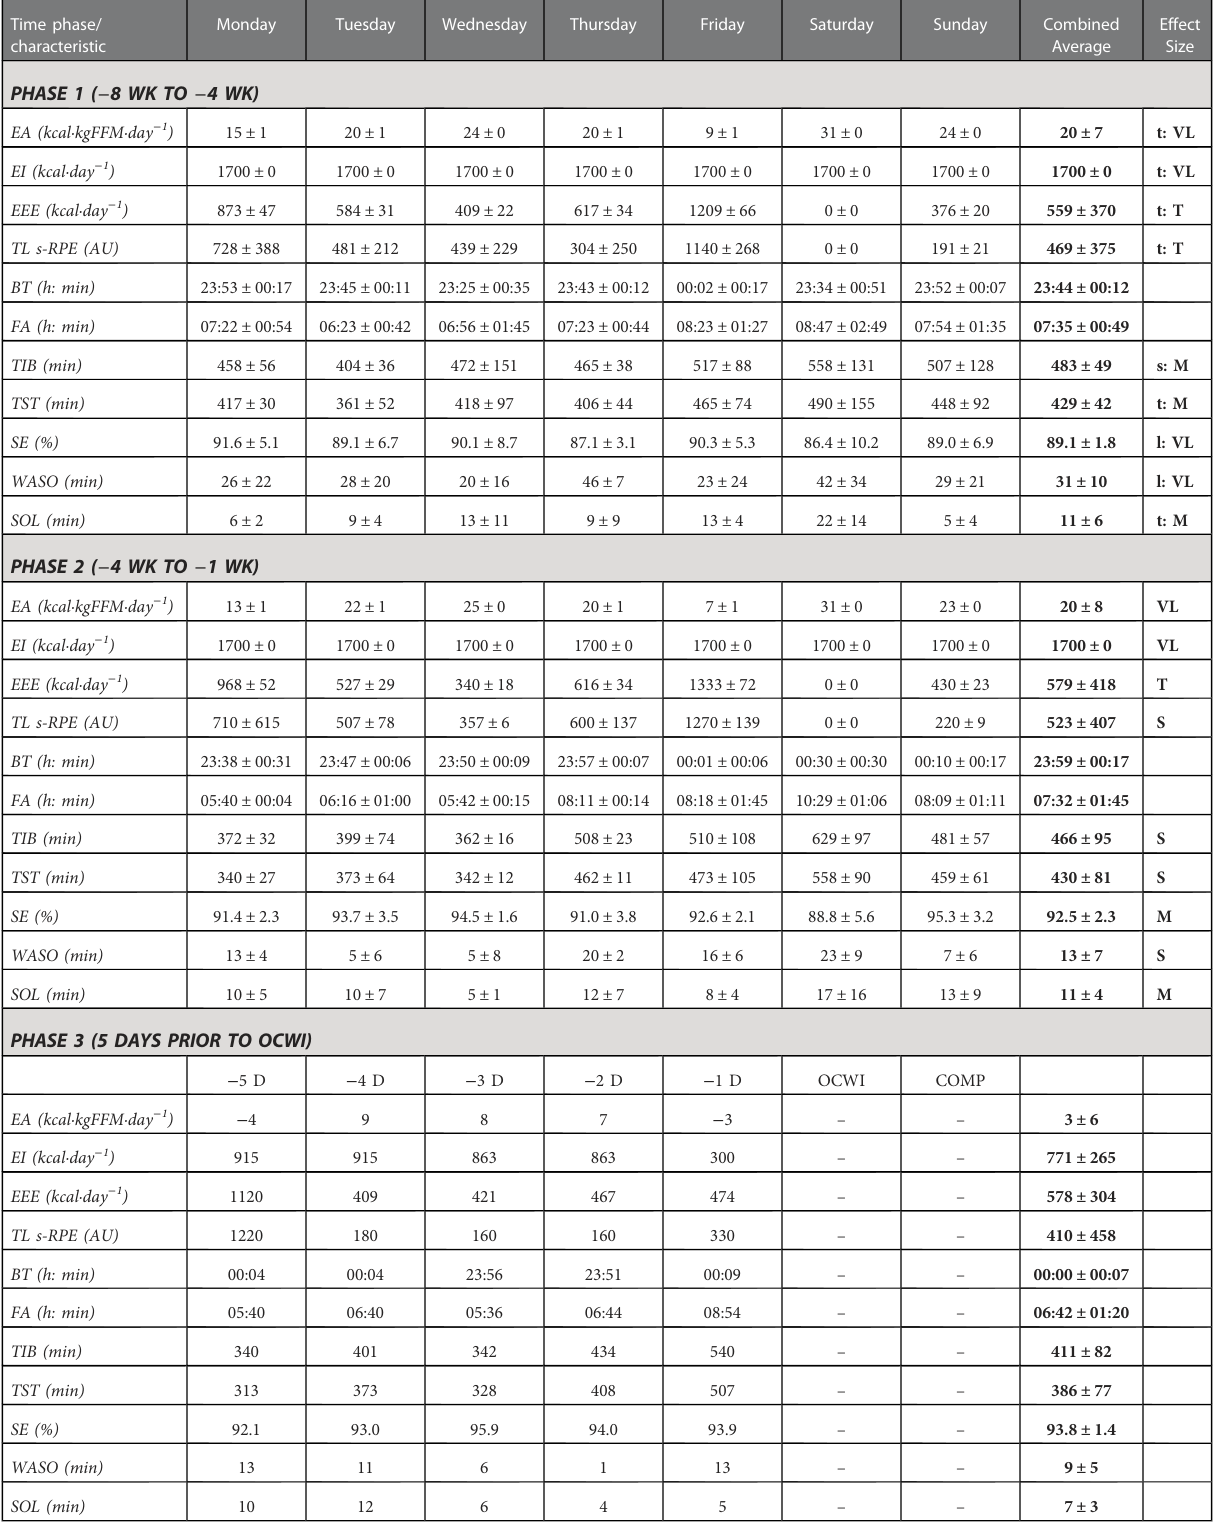
TABLE 1 Measurements of energy availability, intake, expenditure, training load and sleep throughout the training